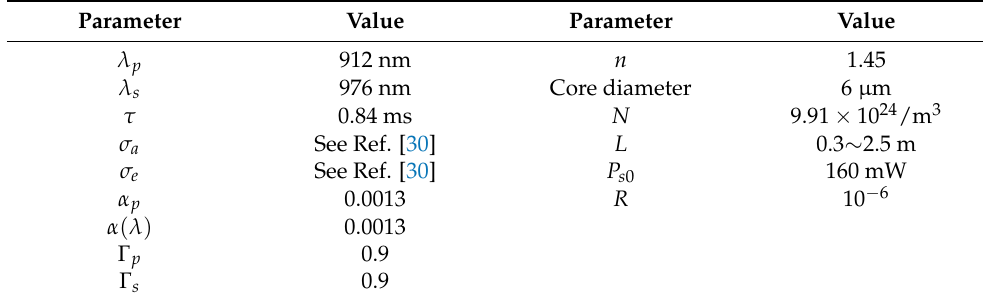
Table 1. Parameters used in the simulation.